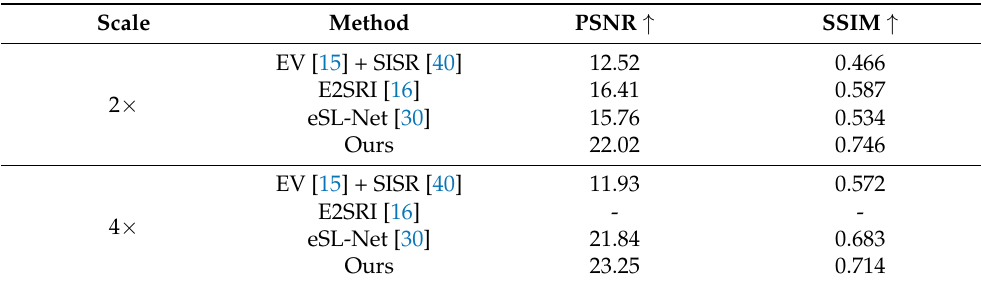
Table 1. Quantitative evaluation of 2 × and 4 × SR. ↑ means the higher (lower), the better results throughout this